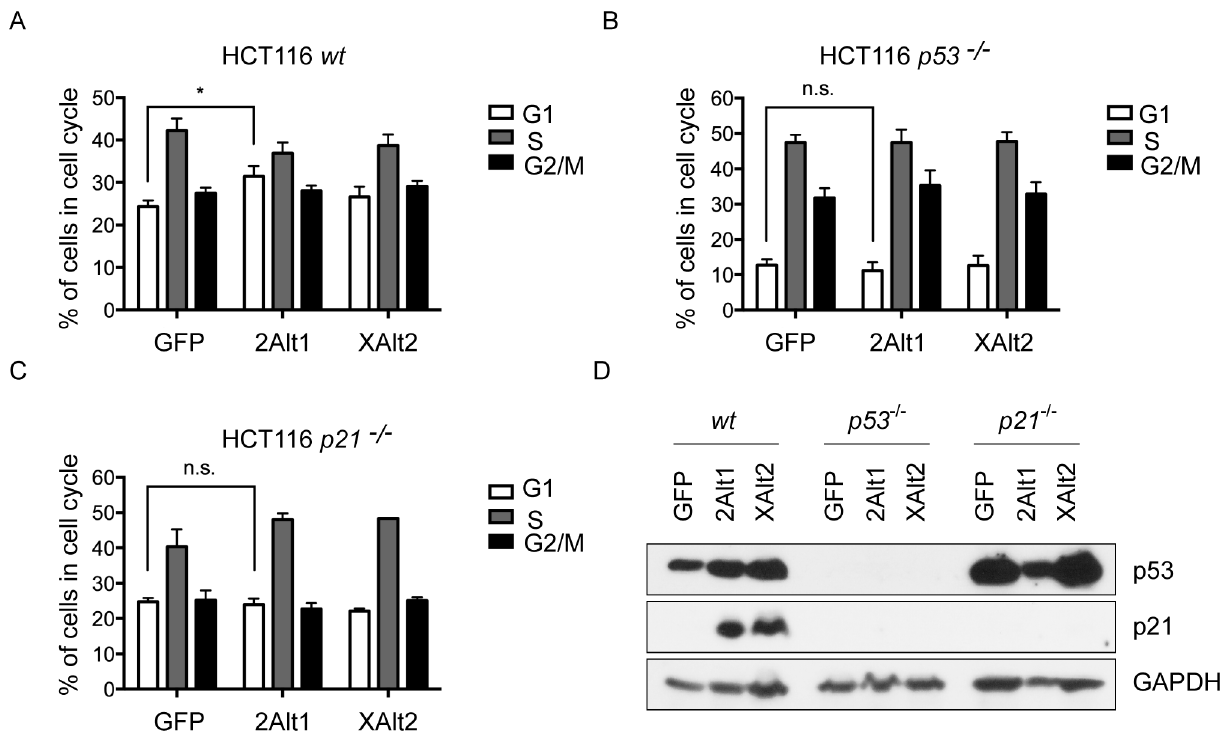
Figure 3. MDM2-ALT1 over-expression leads to G1 phase cell cycle arrest in a p53-dependent and p21-dependent manner. A. HCT116 wild-type (wt), B. HCT116 p53 2 / 2 and C. HCT116 p21 2 / 2 cells were transfected with myc-tagged GFP or MDM2-ALT1 (2Alt1) or MDMX-ALT2 (XAlt2), harvested 24 hours post-transfection and stained with propidium iodide solution and sorted for DNA content. The bar graphs represent the percentage of cells in the various phases of the cell cycle. Error bars represent the standard error mean from at least 3 independent experiments. HCT116 cells that are wildtype (A) show significantly higher percentage of cells in G1-phase upon MDM2-ALT1 expression (31.44% 6 2.45 SEM) compared to GFP-expressing cells (24.40% 6 1.40 SEM; n=5, p =0.0369). In case of MDMX-ALT2 over-expression in HCT116 wildtype cells, there is no significant change in percentage of cells in G1 phase compared to negative control GFP-expressing cells ( p = 0.4389). HCT116 cells that are null for p53 (B) or p21 (C) do not show any differences in the percentage of cells in any of the cell cycle phases upon over-expression of GFP or MDM2-ALT1 or MDMX-ALT2. D. Representative immuno blot showing expression of p53, p21 and loading control GAPDH in HCT116 wt , p53 2 / 2 and p21 2 / 2 cells.